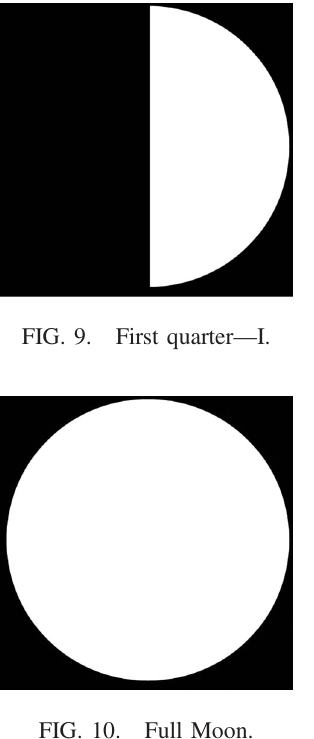
FIG. 10. Full Moon.